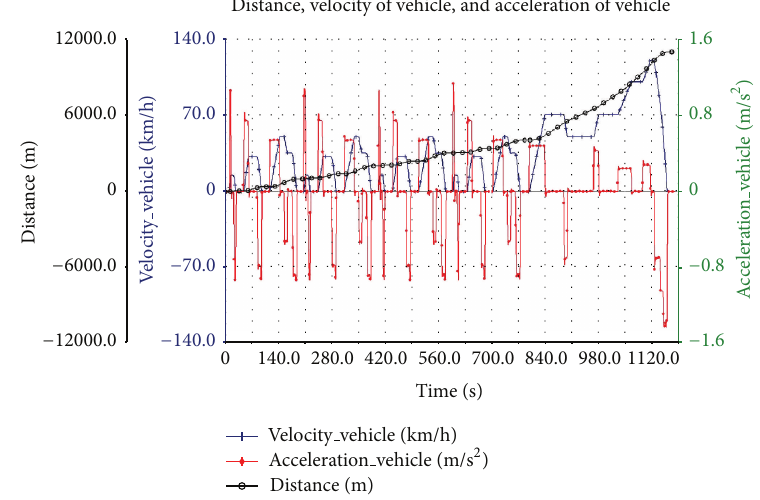
Figure 4: NEDC drive cycles and vehicle state of motion.